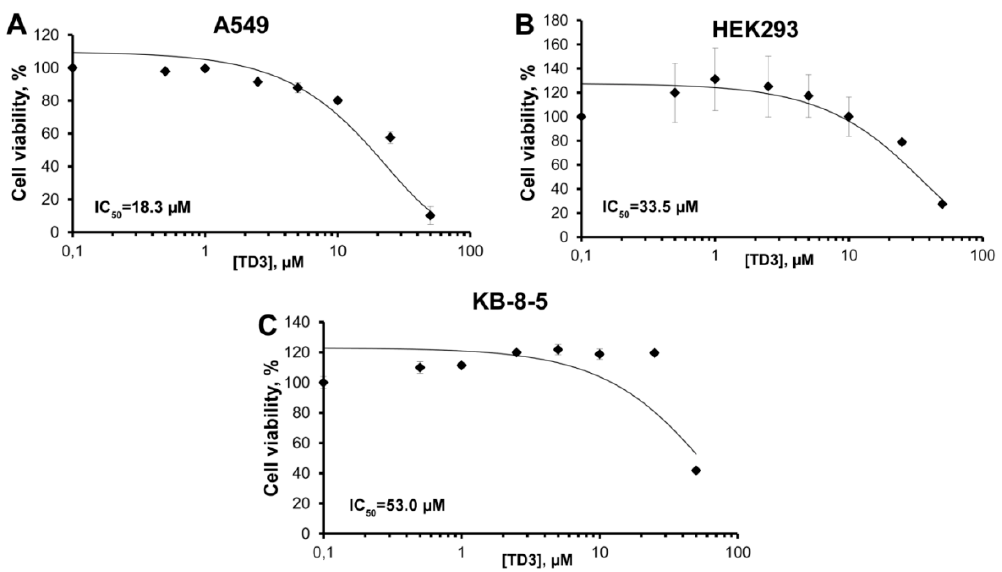
Figure 3. Dose-response curves of TD3 for A549 ( A ), HEK293 ( B ) and KB-8-5 ( C ) cells. Cells were incubated with increasing concentrations of TD3 for 24 h. Cell viability was measured by an xCELLigence instrument in real-time mode. The results are expressed as a percentage of viable cells observed after treatment with TD3 vs. control cells (100%) incubated in the absence of TD3. All experimental points were run in triplicate for statistical analysis. Data are presented as MEAN ± SD.